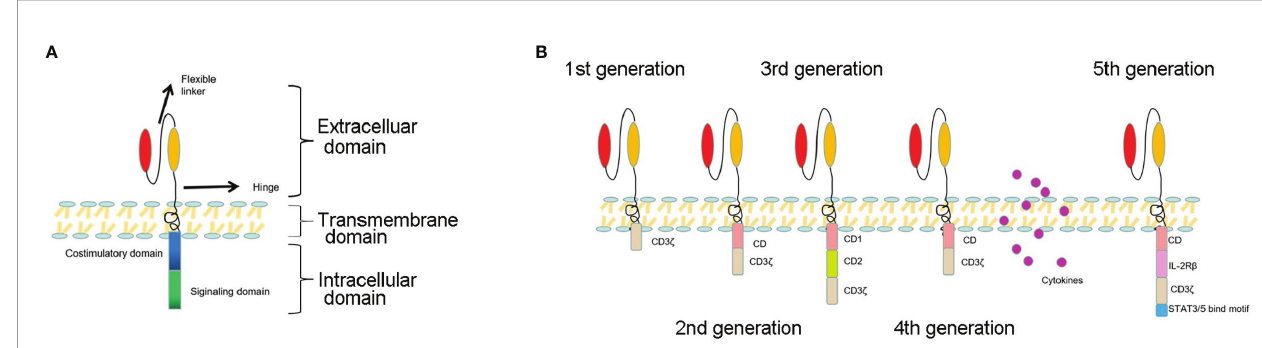
FIGURE 1 | (A) The basic structure of a CAR: extracellular domain, transmembrane domain, and intracellular domain. (B) The development of the fi ve generations of CARs. The fi rst generation only contained the CD3 z chain functional energy domain9; the second generation contained CD3 z + a costimulatory molecular domain (CD28, 4-1BB, etc.); the third generation contained CD3 z and two costimulatory molecular domains; the fourth generation included suicide gene editing, immune factor modi fi cation, and other integrated and re fi ned regulatory tools; the fi fth generation included simultaneous activation of TCR, costimulatory domain, and cytokine triple